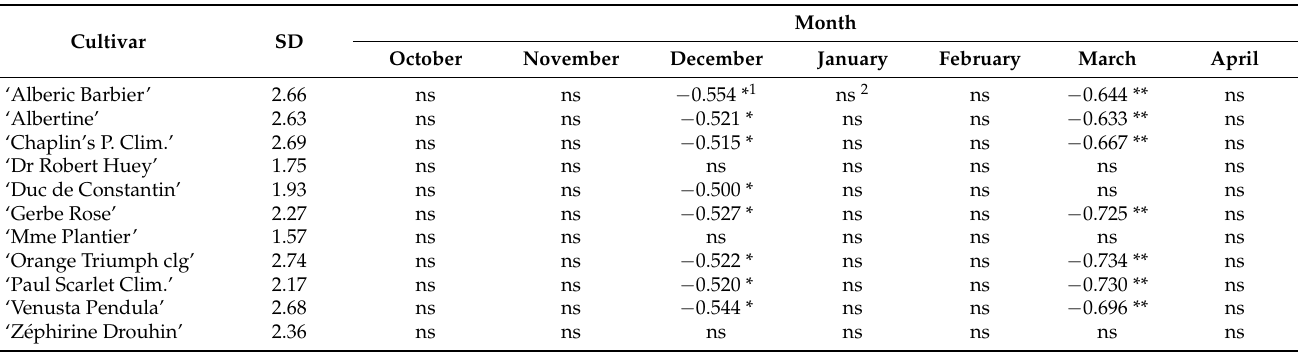
Table 4. The effect of correlations between frost damage of climber roses and minimum monthly air temperatures (2005/2006, 2009/2010,